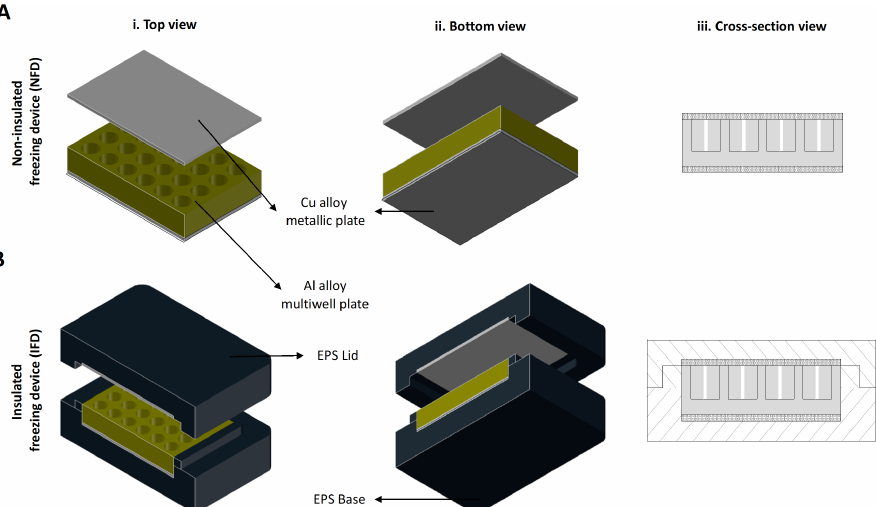
Figure 1. Scheme of the (i) top, (ii) bottom and (iii) cross-section view of the freezing devices. ( A ) The non-insulated freezing device (NFD) contains a conductive aluminum multiwell plate, with a cover and a base of a thermo-conductive copper alloy. ( B ) The insulated freezing device (IFD) is composed by the same components of the NFD and an insulating outer shell. EPS—expanded polystyrene.